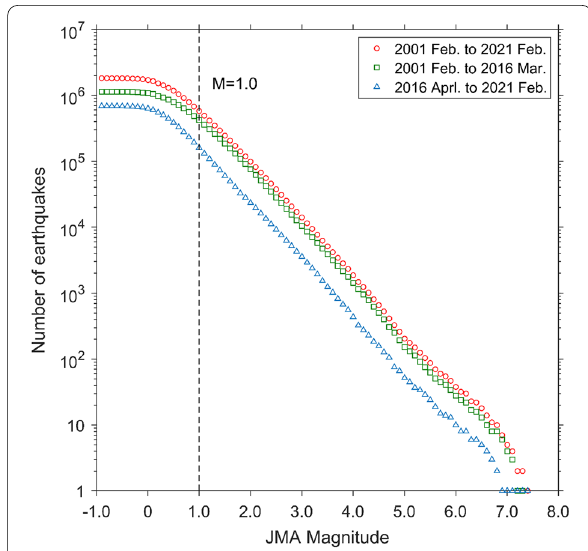
Fig. 1 Cumulative number of shallow onshore earthquakes in Japan from the JMA earthquake catalogue. The red circles, green squares and blue triangles show the time period from 2001 to 2021, 2001 to 2016 and 2016 to 2021, respectively. There was a change for the earthquake detection processing system in 2016. The black dashed line indicates the earthquake completeness level cutting at Mj1.0 used in this study